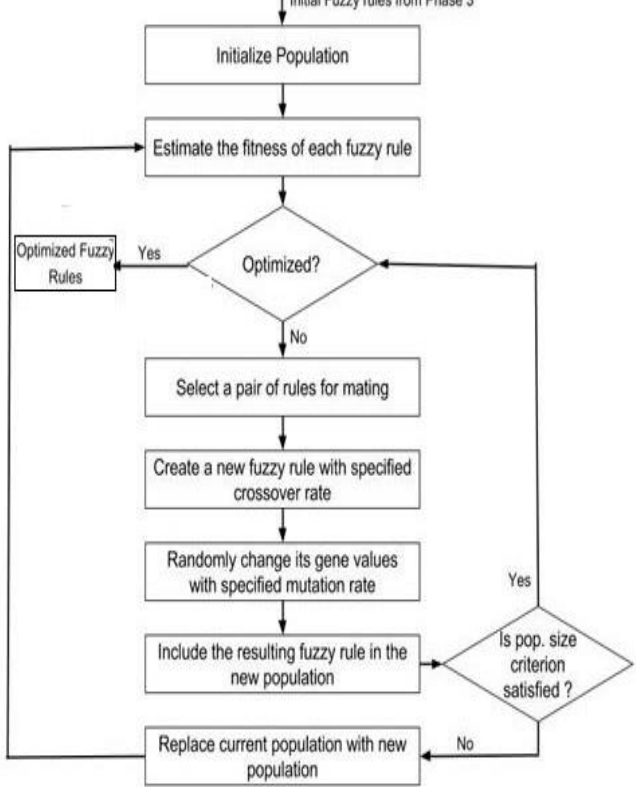
Figure 2 . GA based approach for feature set